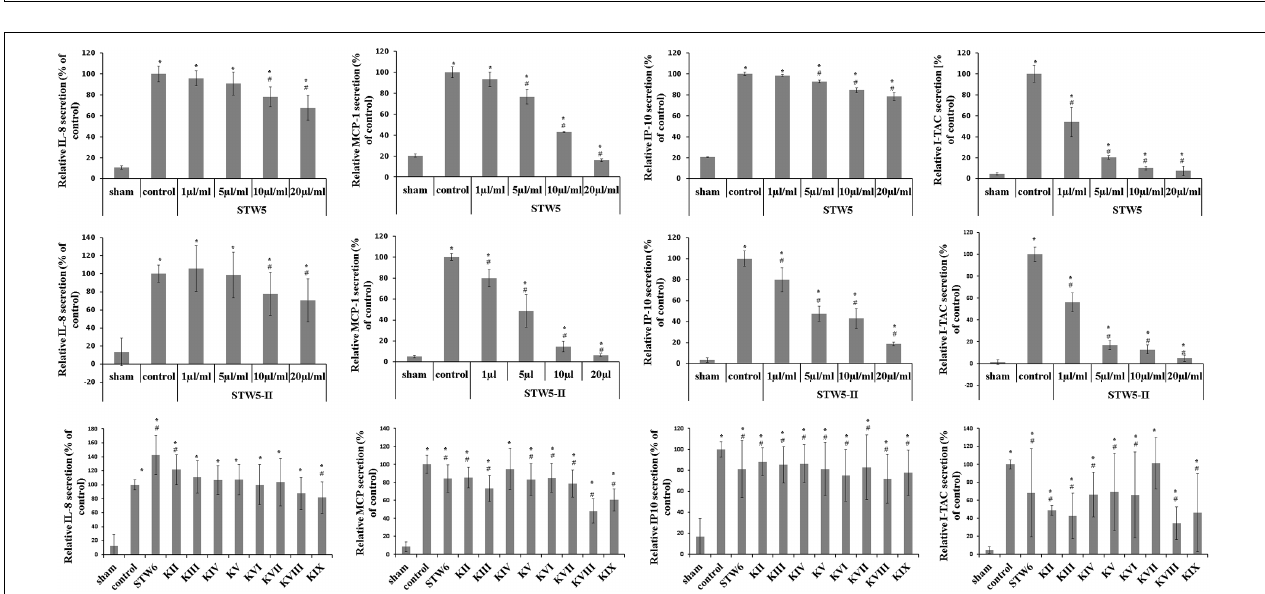
FIGURE 3 | Dose-dependent effects of STW5, STW5-II, and single plant extracts on cytokine release. NCM460 cells were treated with STW5 or STW5-II (1; 5; 10; 20 µ l/ml) or single plant extract (percentage of STW5-II calculated for 10 µ l/ml according to content in herbal preparation) for 4 h prior to induction with the CM (10 ng/ml TNF- α , 5 ng/ml IL-1 β , and 10 ng/ml IFN- γ ) for 24 h. Supernatants were collected and analyzed by ELISA. # denotes statistical significance at p < 0.05 vs. control, ∗ denotes statistical significance at p < 0.05 vs. sham.